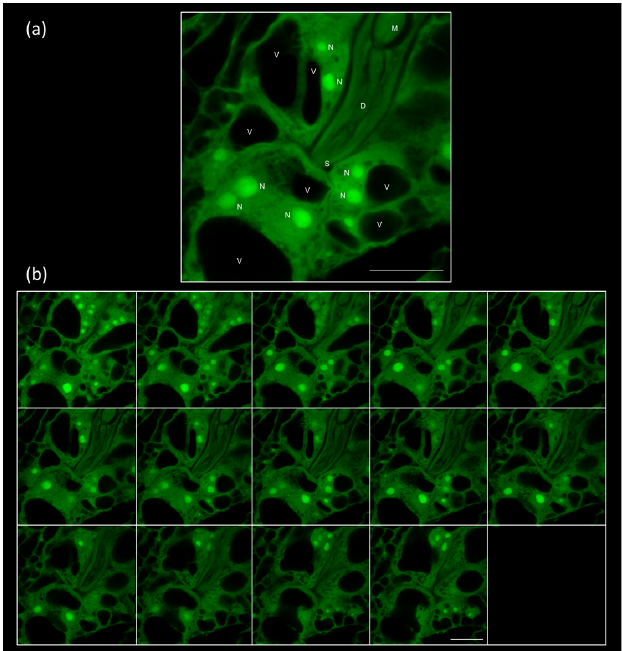
Figure 2. The fixation and clearing method allows the neat visualization of the plant-nematode interface. ( a ) Image of a feeding site at 48–72 h post infection derived from the Z-Stack (Sum) of images 5–9 from ( b ) a montage of 14 1- μ m optical sections from a gall induced by Meloidogyne javanica in Arabidopsis thaliana roots at 48–72 h post infection. The images were taken from entire galls after fixation with glutaraldehyde and clearing with BABB. Scale bars: 20 μ m. Confocal parameters: PMT 1 (Offs.): − 5.70. PMT 1 (HV): 494.13. Excitation beam splitter FW RSP 500. λ ex/ λ em 480 nm/500–600 nm. Pinhole (airy) 1.00. D: dorsal gland; M: metocorpus; N: nucleus; S: stylet; V: vaculole.